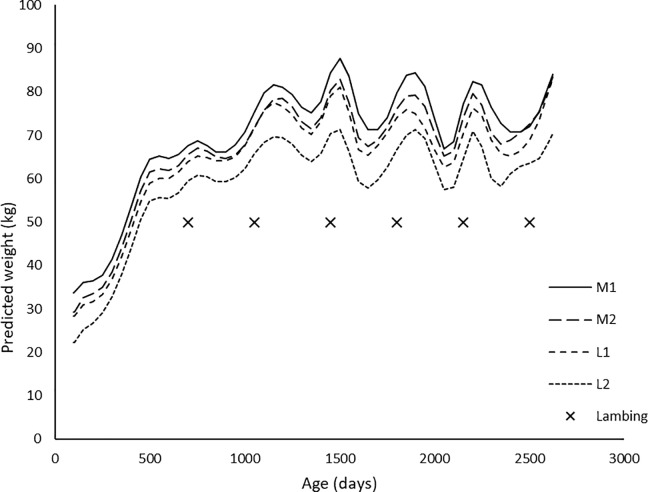
Spline fit (knots at breeding, lambing and weaning each year) predictions of daily live weight of ewes from their weaning (D99) to the weaning of their last lambs (D2623) for the interaction of dam age group and birth rank.M1 = singleton born to a mature ewe, M2 = twin born to a mature ewe, L1 = singleton born to a ewe lamb, and L2 = twin born to a ewe lamb. Times marked with an x indicate lambing dates each year (Days 692, 1057, 1442, 1790, 2146, and 2507).